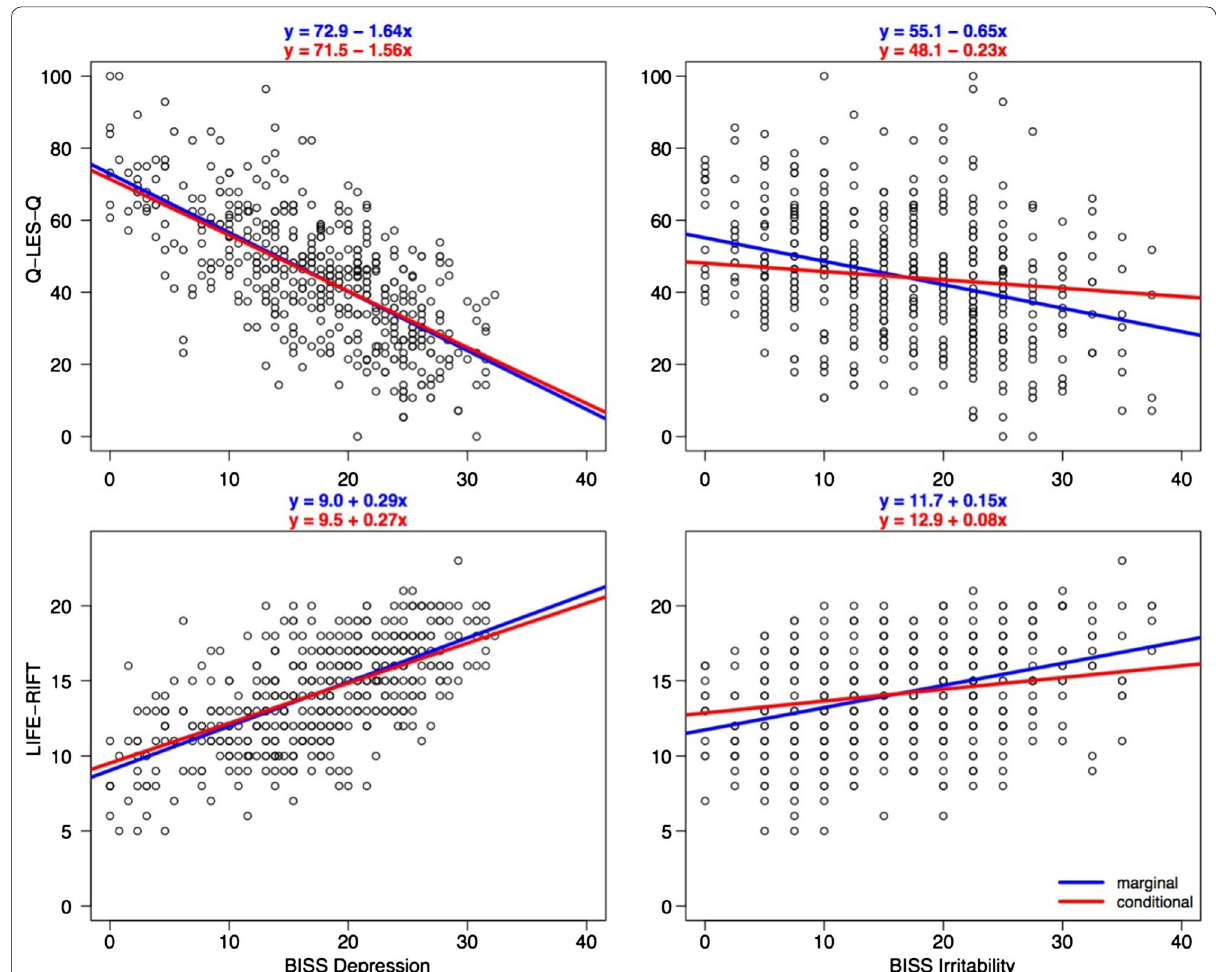
Fig. 1 Marginal and conditional effects of depression and irritability on quality of life and functioning. In this figure, we display the marginal (unadjusted) and conditional (adjusted for other covariate in model) effects of depressive and irritability symptom severity on quality of life and functioning. In both cases, the marginal and conditional effects of BISS depression were similar, while the effect of BISS irritability decreased when adjusting for BISS